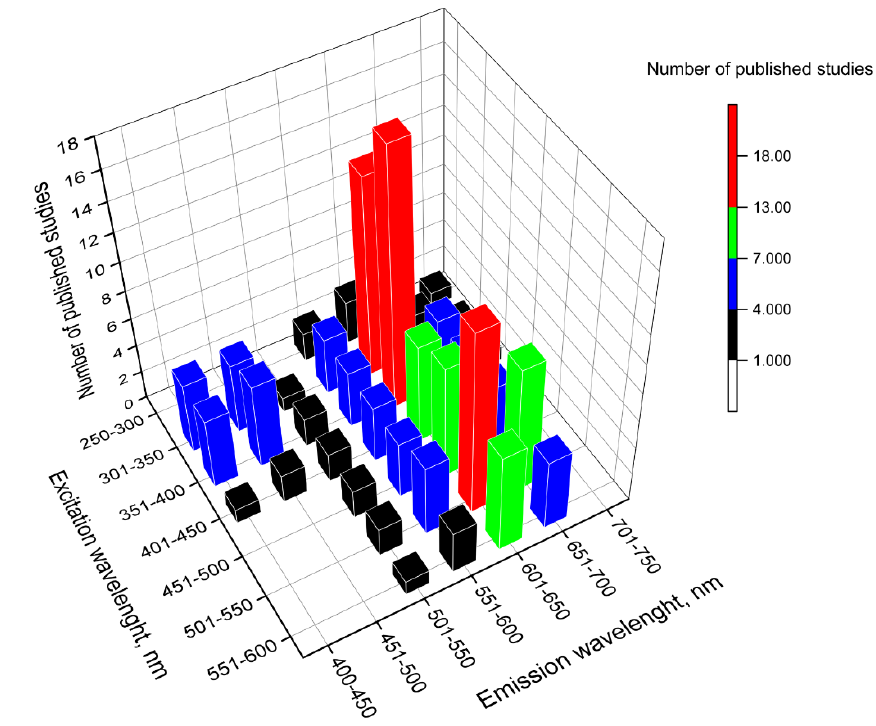
Figure 6. Spectral properties of photoconversion covers used for agriculture.